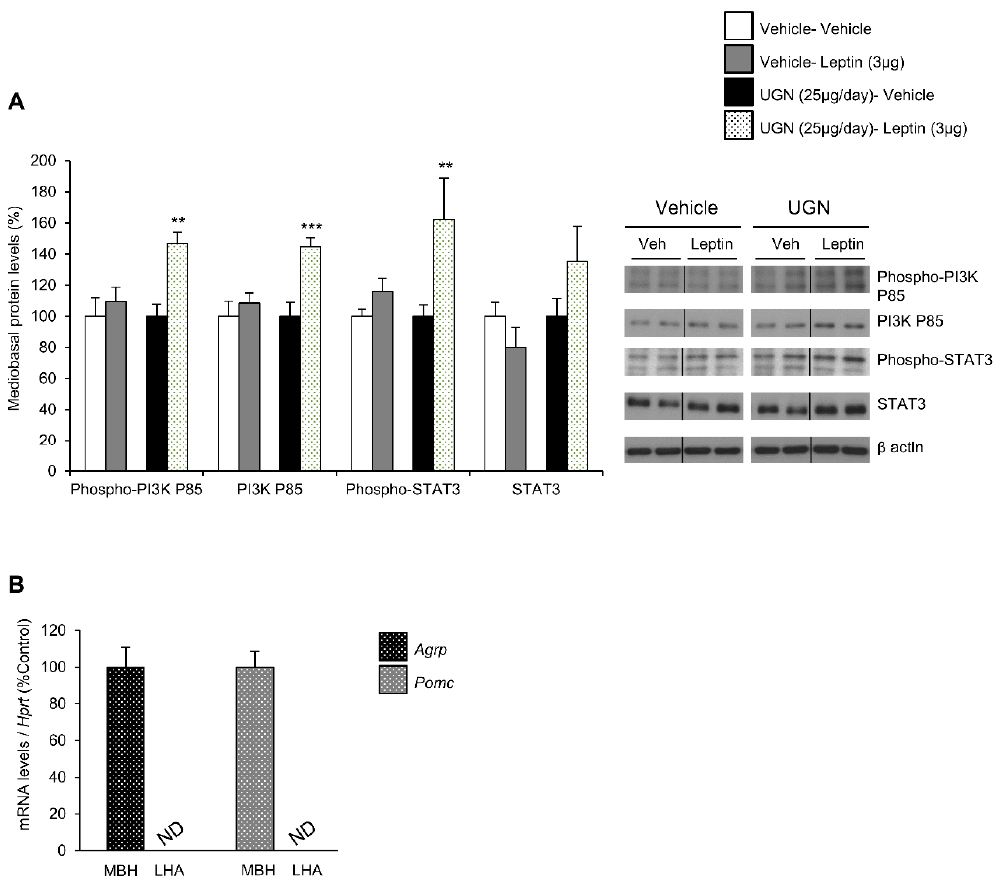
Figure 2. Evaluation of mediobasal hypothalamic levels of Phospho-PI3K P85, PI3K P85, Phospho-STAT3, STAT3 following an ICV leptin injection (3 μ g/mouse) (the mice being pretreated with UGN (25 μ g/mouse/four days) and submitted to fasting the night before leptin injection). The mice were sacrificed and the tissues collected 15 min after leptin injection. Values are expressed in relation to β -actin levels. Dividing lines indicate splicing within the same gel ( A ). mRNA expression of Agrp and Pomc in mediobasal and lateral hypothalamus ( B ). Values were expressed relatively to Hypoxanthine-guanine phosphoribosyltransferase ( Hprt ) levels. ND: non detected. Values are mean ± SEM of 8 animals per group. ** p < 0.01, *** p < 0.001 vs vehicle.